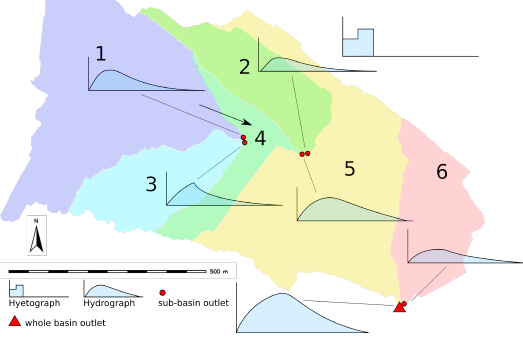
Figure 7. Simple example of possible CPU-based parallelization strategy for the experimental catchment Nuˇcice calculated at first in parallel. The calculated hydrographs